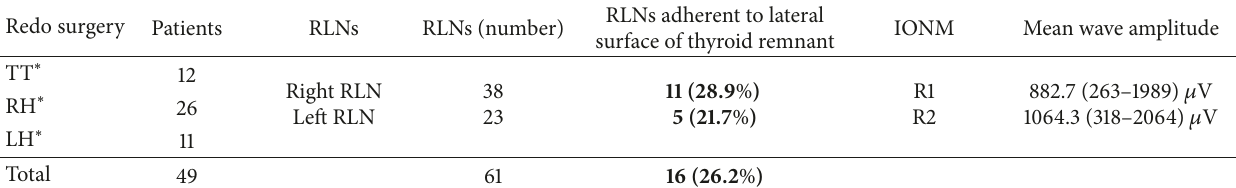
Table 3: Cervical course of recurrent laryngeal nerves and mean wave amplitude levels. Redo